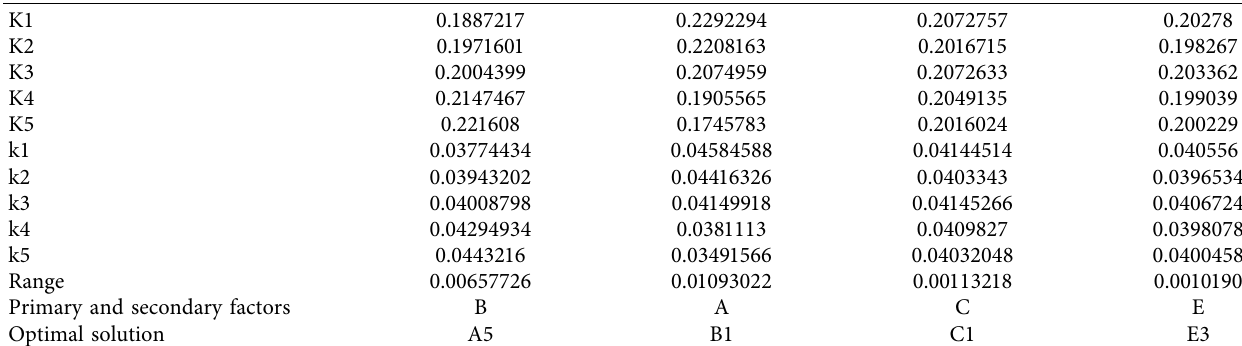
Table 6: Result of range